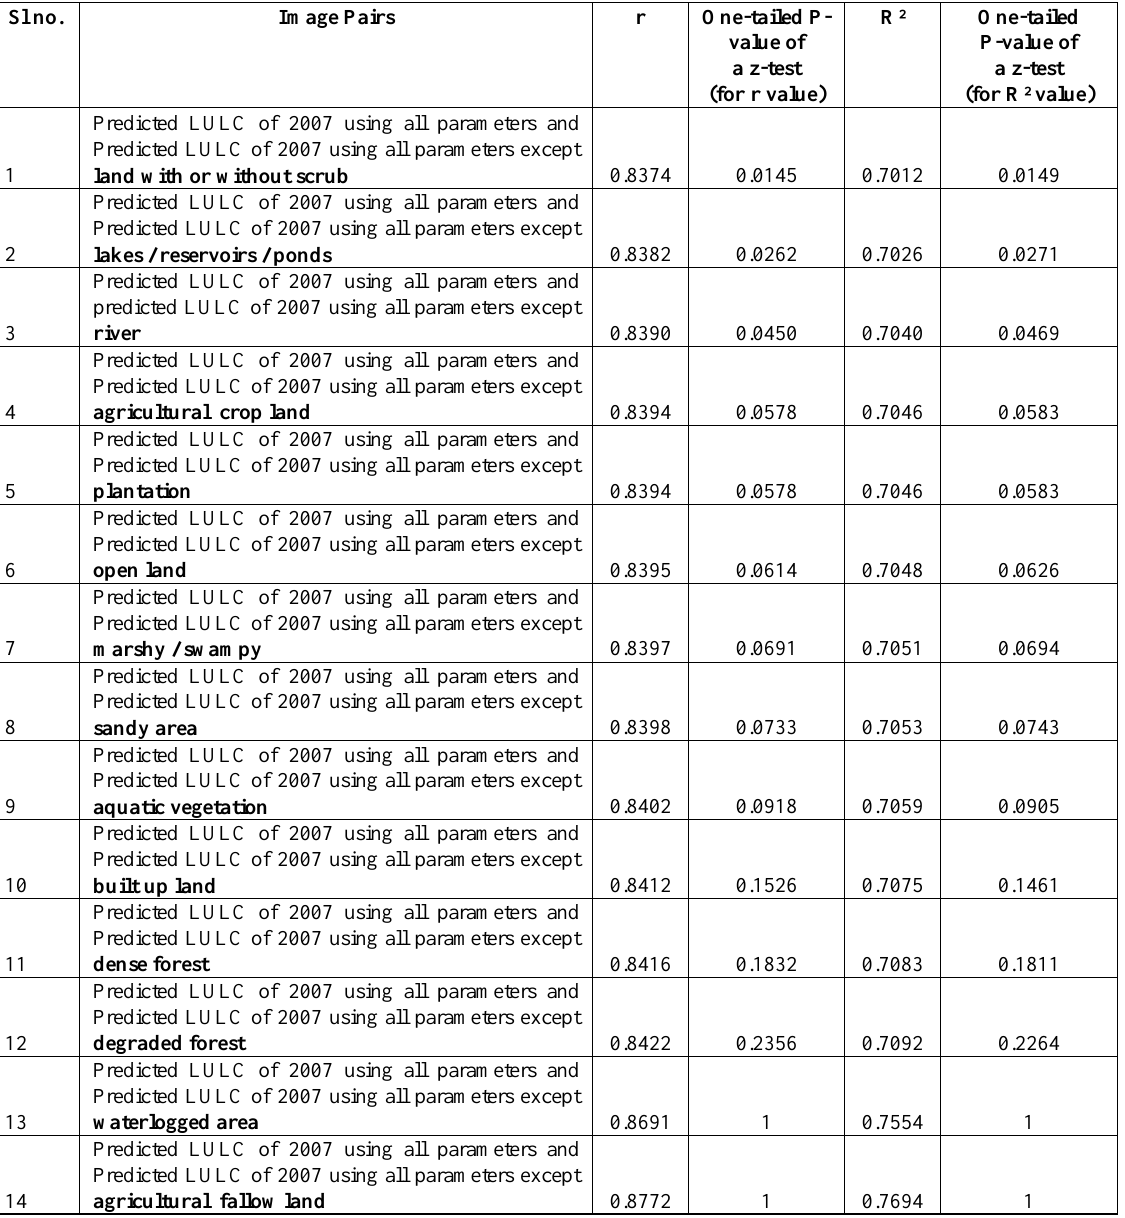
Appendix 3: Ranking (descending order) of relationship between predicted LULC of 2007 using all parameters and predicted LULC of 2007 using all parameters except any one parameter Sl